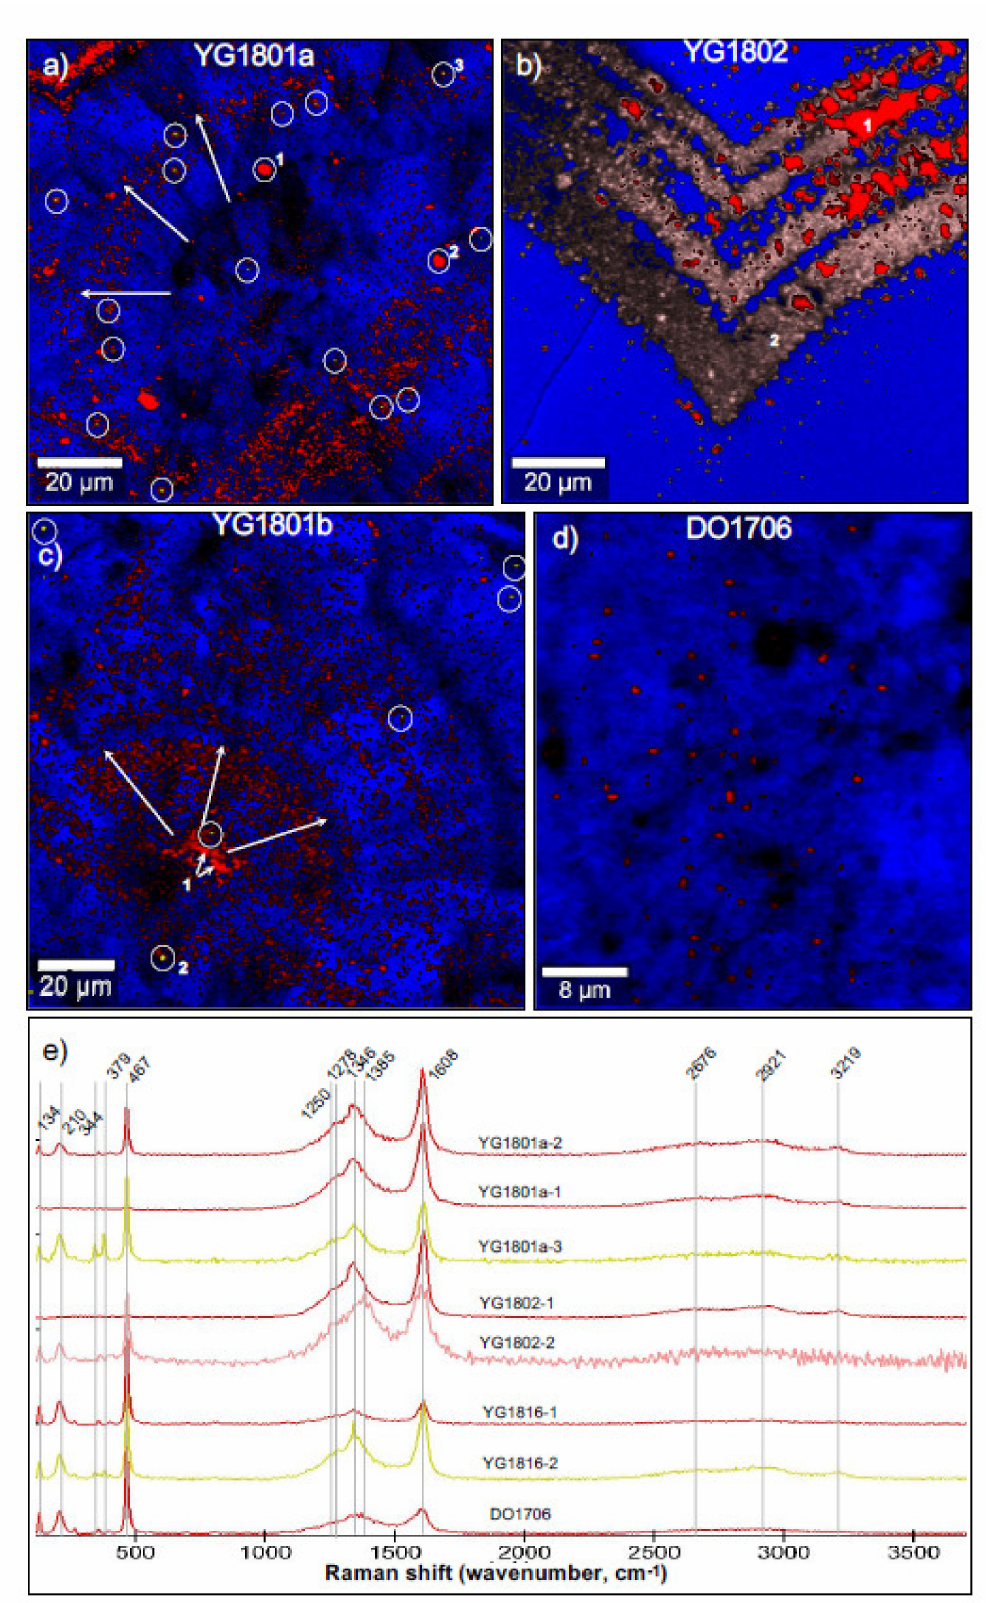
Figure 7. Raman hyperspectral images of organic matter in Doushantuo cap carbonate member 1. ( a ) Hyperspectral image of organic matter (red) associated with radially aligned acicular quartz (blue) and nanoscopic pyrite (yellow) (YG1801a,